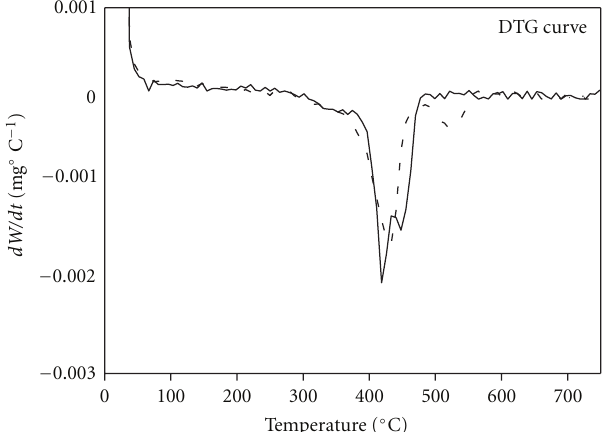
Figure 5: DTG profiles for Nafion-117 (solid line) and Nafion-117/ DTA + (dashed line) membranes.